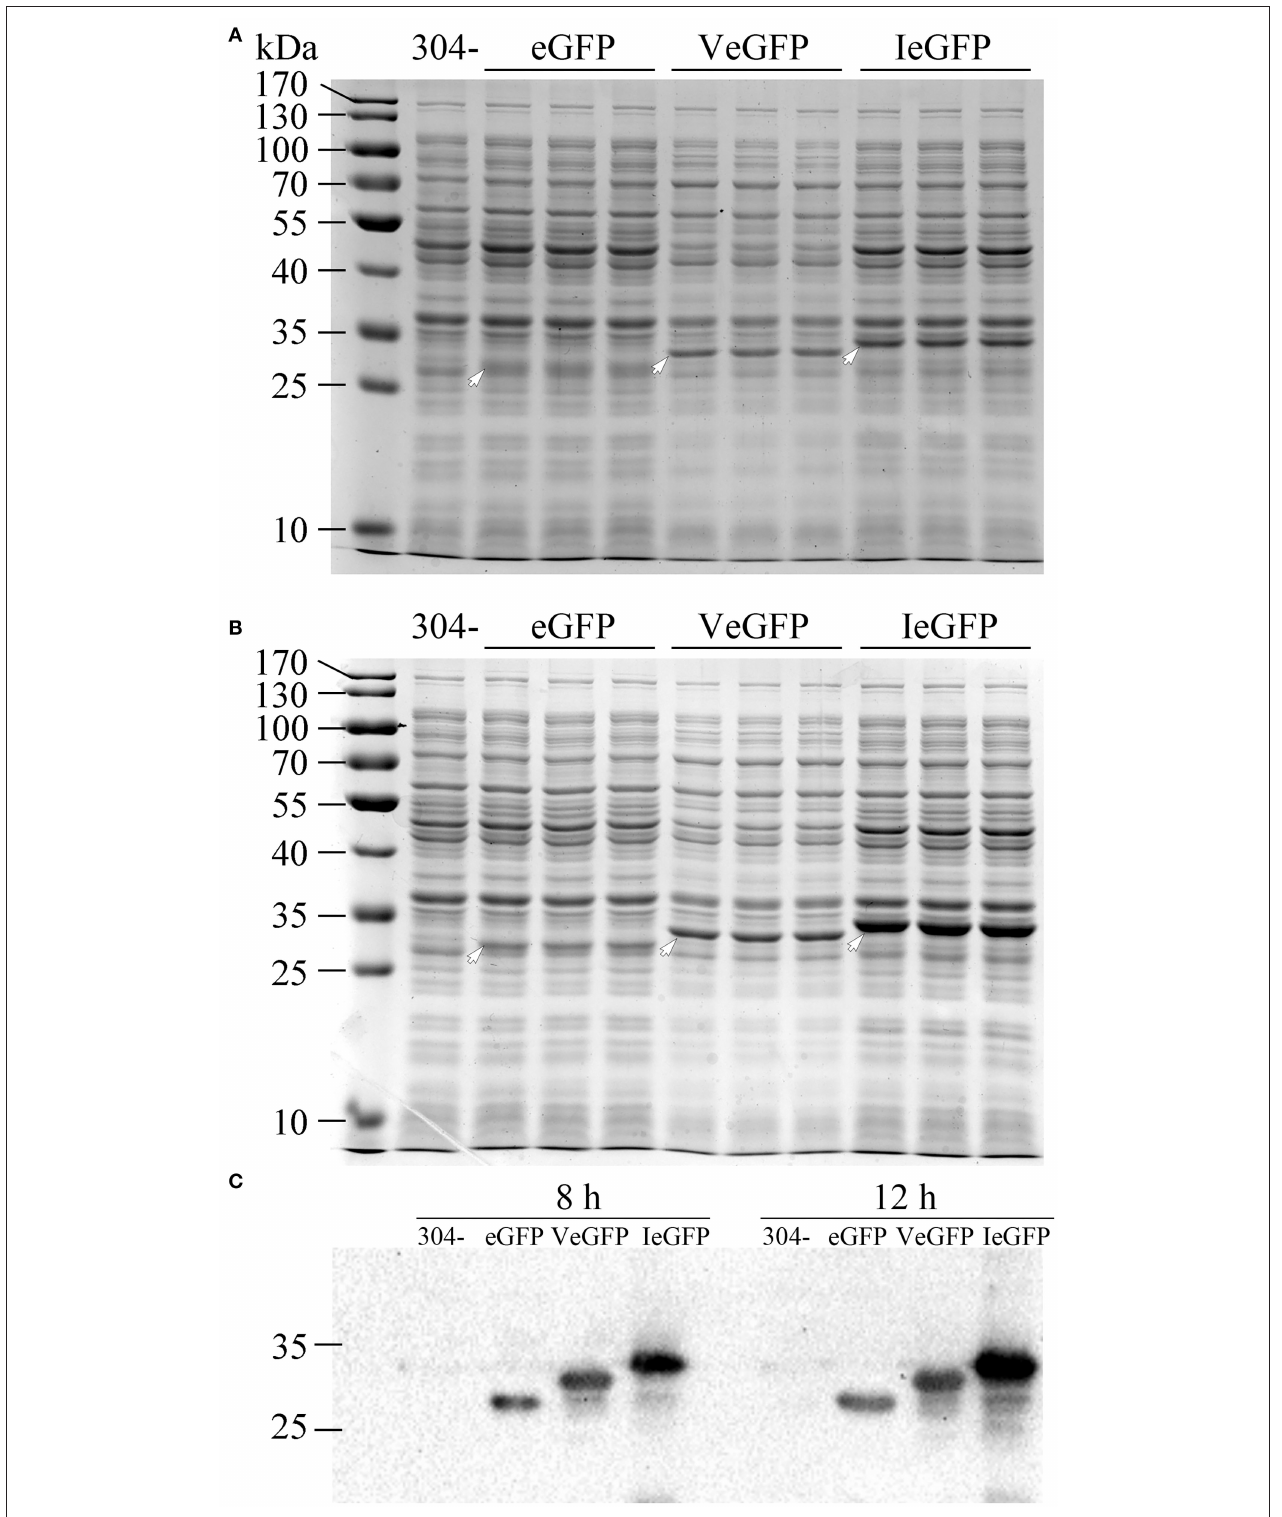
FIGURE 3 | The expression of VeGFP in the E. coli MC4100 strain controlled by the constitutive promoter P ac . The samples of eGFP (27.9 kDa), VeGFP (lane 2, 31.8 kDa), and IeGFP (lane 3, 33.1 kDa) were prepared at 8 (A) and 12h (B) after inoculation, respectively. Lane “–” is the negative control prepared from M304 cells. Lane “M” is the molecular weight standard. The arrows indicate the target bands of the recombinant proteins. The target proteins were also verified by western blot (C) .